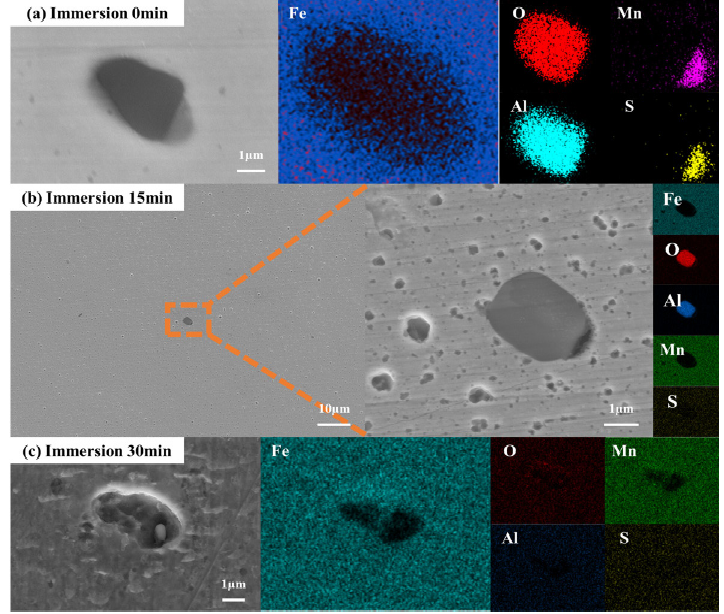
Figure 4. ( a ) The morphology and composition of inclusions in the steel, and the in situ immersion FE-SEM-EDS images of Al 2 O 3 -MnS inclusions after immersion ( b ) 15 min and ( c ) 30